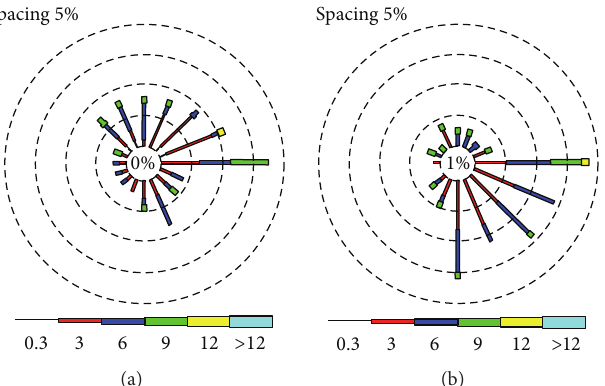
Figure 4: Wind rose of buoy B at 08:00 LST (a) and 16:00 LST (b) based on hourly wind in August of 2005–2008 (Color scale: mean wind speed; ray direction: wind direction; ray length: frequency of wind direction; value in the circular: frequency of calm wind).